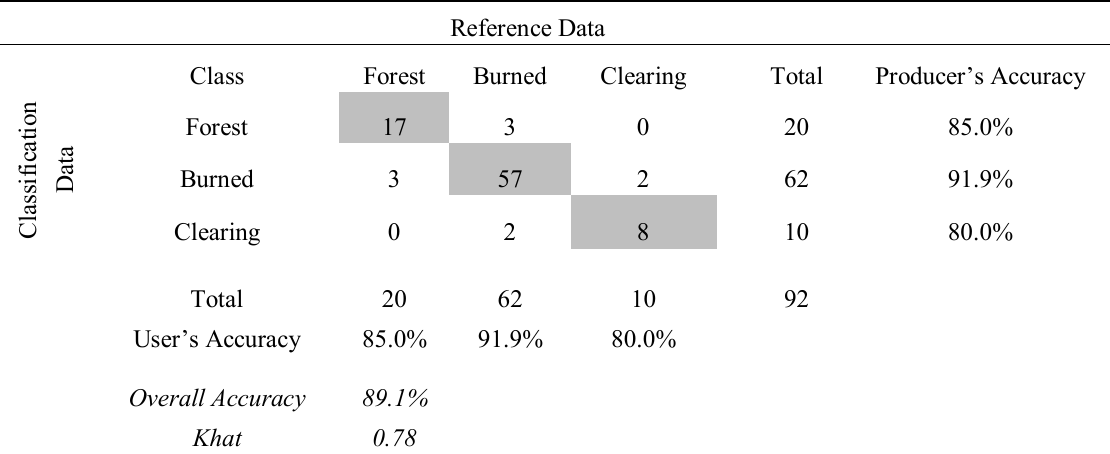
Table 3. Classification accuracies summarized in a confusion matrix for each hierarchical level. Level III: Validation of LULC Forest and Burned Classes Only.